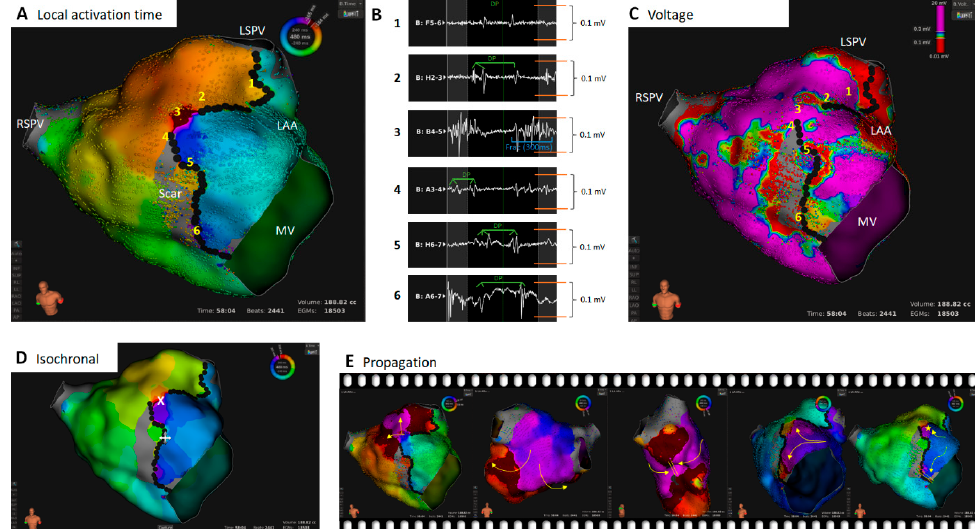
Figure 1. Patient with a persistent AF and a history of previous RF isolation of the PVs. The cycle length of the AT was 480 ms. Shown is the ultra high-resolution map with the Rhythmia HDx™ 3D mapping system. ( A ): Local activation time map of the left atrium. Black dots represent locations with double potentials (DP). ( B ): Local bipolar electrograms. The numbers correspond to the locations in the LAT ( A ) and voltage map ( C ). ( C ): Voltage map; signal amplitude (sa) > 0.3 mV = violet, sa < 0.1 mV = red, 0.1 mV > sa < 0.3 mV = rainbow color, sa < 0.015 mV = grey (noise level). Black dots represent locations with double potentials (DP). ( D ): LAT Isochronal, step size 30 ms; critical isthmus marked with a white cross. ( E ): Propagation maps. Summary: The patient presented a macro-reentry AT with one critical isthmus. The dominant reentry propagated across the roof around the left PVs ( A , E ). A large scar area at the anterior wall was striking ( C ). The isochronal map showed slow conduction at the upper and lower end of the scar area ( D ). Based on the voltage map ( C ), it was not feasible to delineate the distinct borders of the slow conducting area. A review of the electrograms revealed double potentials in areas 1 and 2 ( B ). However, another breakthrough at the lower end of the low voltage area appeared to be possible. Again, an electrogram review revealed double potentials in areas 4 – 6 ( B ). Of note: all signals which had two peaks within one AT cycle and were separated by an isoelectric line were classified as double potentials. This was also true if the single peaks were very close together or fractionated. A highly fractionated electrogram was found in area 3. Therefore, this spot was defined as a critical isthmus. The ablation strategy was a critical isthmus ablation only, which terminated the AT during the first RF delivery. Abbreviations: LSPV = left superior pulmonary vein; RSPV = right superior pulmonary vein; MV = mitral valve; LAA = left atrial appendage; DP = double potential.